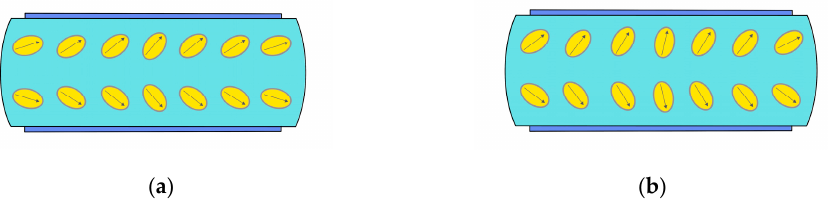
Figure 7. Variation diagram of magnetic domain under different magnetic induction intensity. ( a ) 105.35 kA/m. ( b ) 14.74 kA/m.